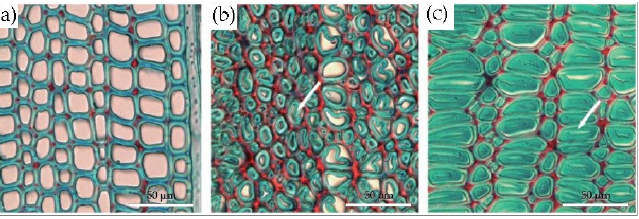
Figure 4. Transverse sections of three types of tropical tension wood stained with Safranin O/Fast Green [38] (arrows indicate the gelatinous layers): ( a ) Fiber cells of Virola michelii without gelatinous layers, which are similar to normal fiber cells; ( b ) gelatinous fibers of Inga alba , whose gelatinous layers’ thicknesses are similar to that of their adjacent layers; ( c ) gelatinous fibers of Sextonia rubra with thick gelatinous layers and negligible cavities.